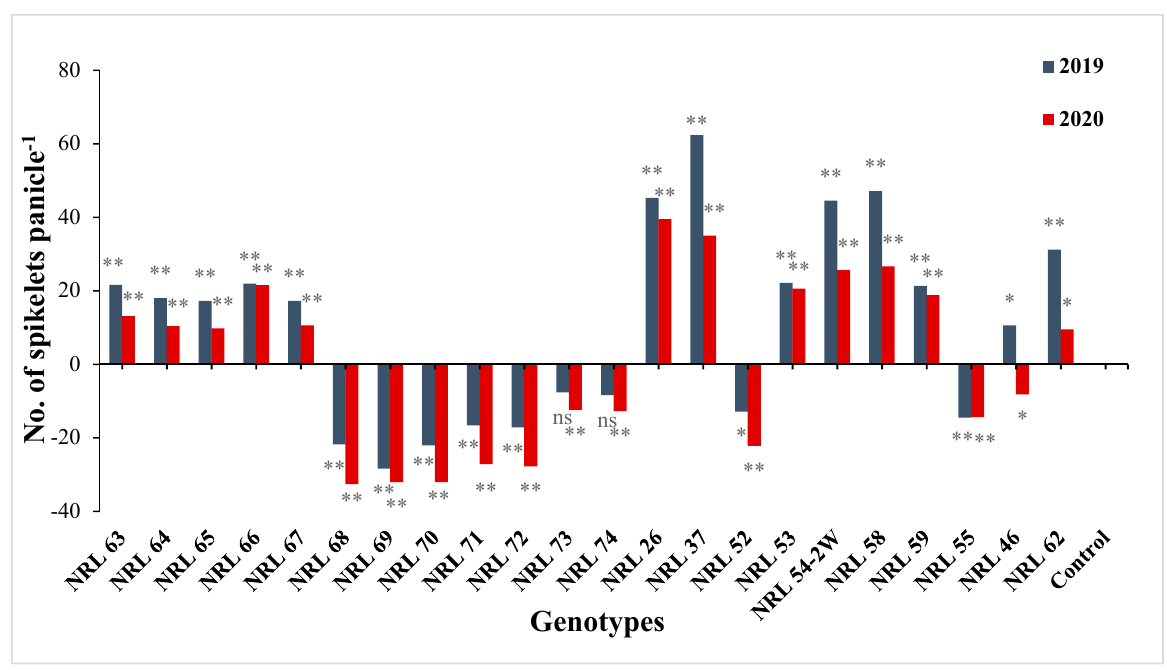
Figure 7. The percentage of advantage over commercial variety for number of spikelets per panicle of studied genotypes during the 2019 and 2020 growing seasons. Means **: Highly significant at 1%; *: Significant at 5%; ns: Non-significant.